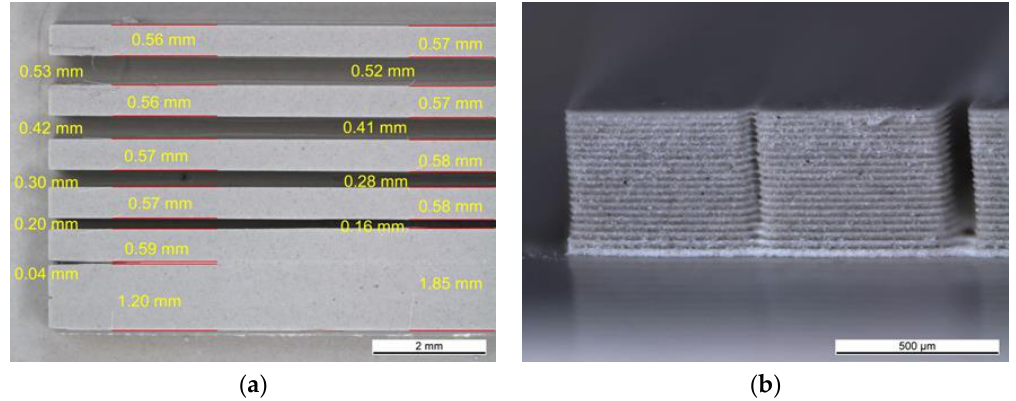
Figure 10. Plate with channel structure fabricated on the LCM device from a suspension containing 2.0 wt % TPO-L. ( a ) top view, ( b ) side view.